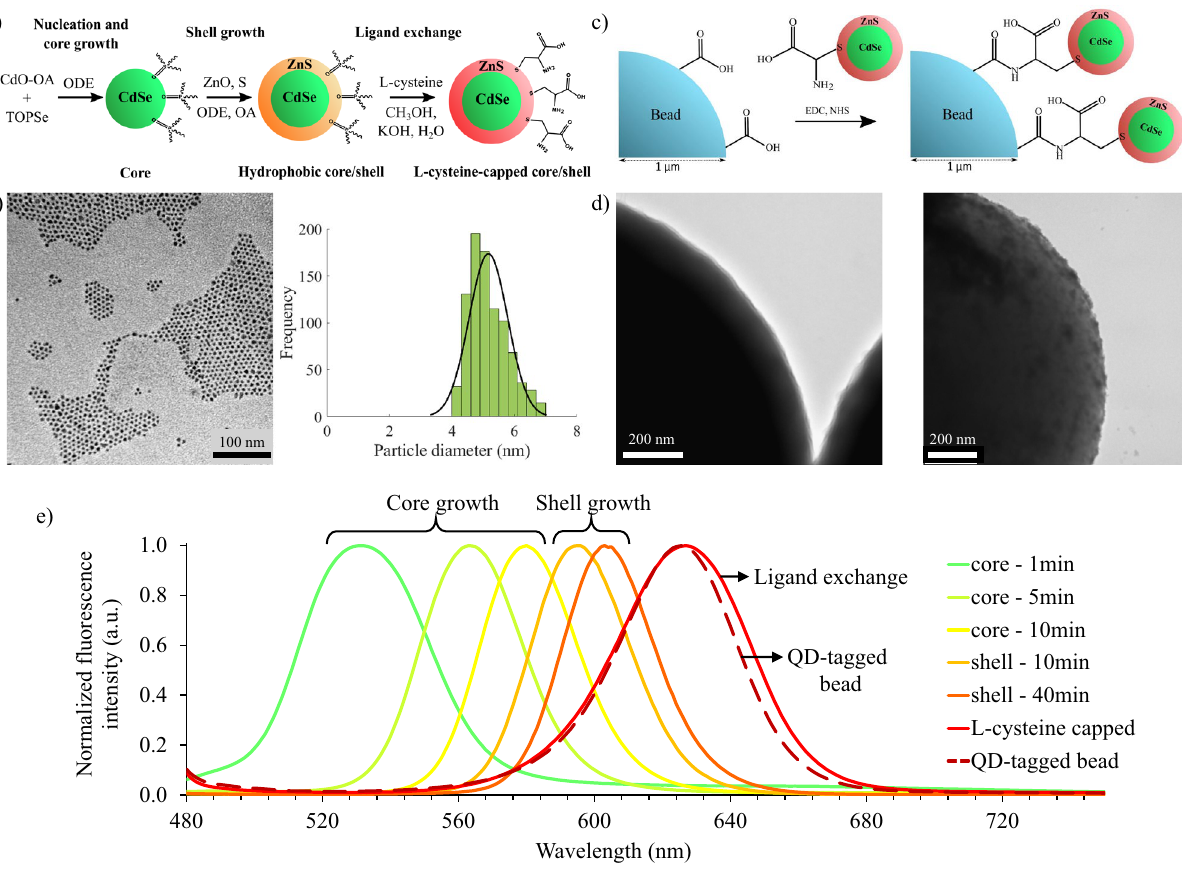
Figure 1. Synthesis steps and salient characterization of the QDs and QD-tagged beads. ( a ) L-cysteine capped CdSe/ZnS QD synthesis steps. ( b ) TEM image of CdSe/ZnS QDs with their corresponding size distribution; the average diameter was 5.2 ± 0.6 nm. ( c ) The coupling reaction of L-cysteine capped QDs to the surface of micro- sized beads through EDC/NHS chemistry. ( d ) TEM images of the surface of an uncoated polymer (left) and a QD-tagged bead (right), confirming the success of the coupling reaction. ( e ) Fluorescence emission of the QDs at different times throughout the